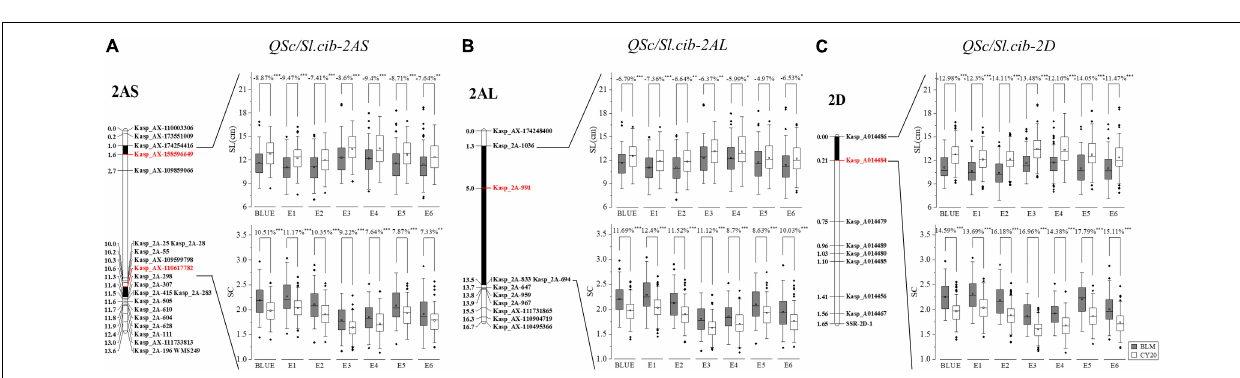
in SC were detected in all the environments and the BLUE dataset ( Figure 5